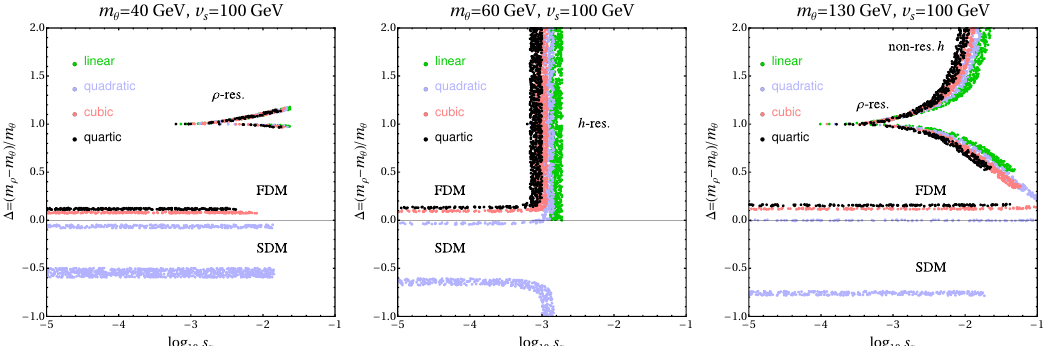
Figure 4. Scan in the normalized mass splitting ∆ versus the (logarithm of the) mixing s α for m θ = 40 , 60 , 130 GeV from left to right, and v s = 100 GeV , for the minimal models described in the text. The green, blue, red and black colors correspond to the linear, quadratic, cubic and quartic models respectively. All these points fulfill the relic abundance condition 0 . 5 6 Ω / Ω also impose the XENON1T and the invisible Higgs decay